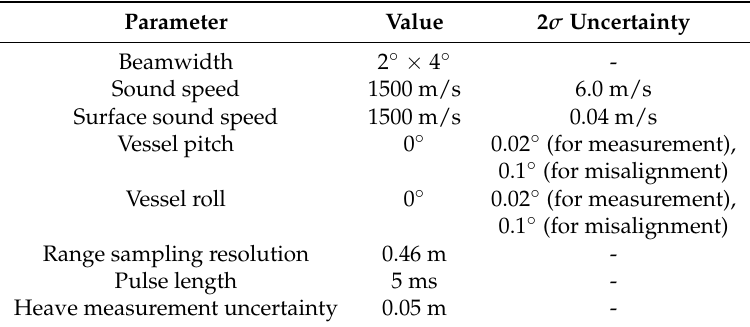
Table 9. Values of parameters necessary for uncertainty